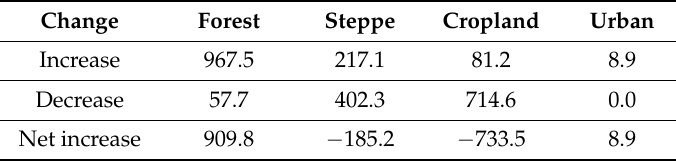
Table 3. Land cover changes in the QYJ Basin from 1985 to 2010 (km 2